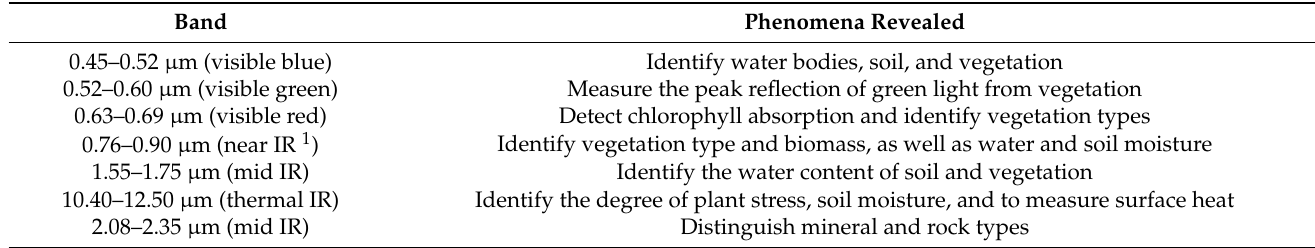
Table 1. Phenomena revealed by different bands of Landsat data.